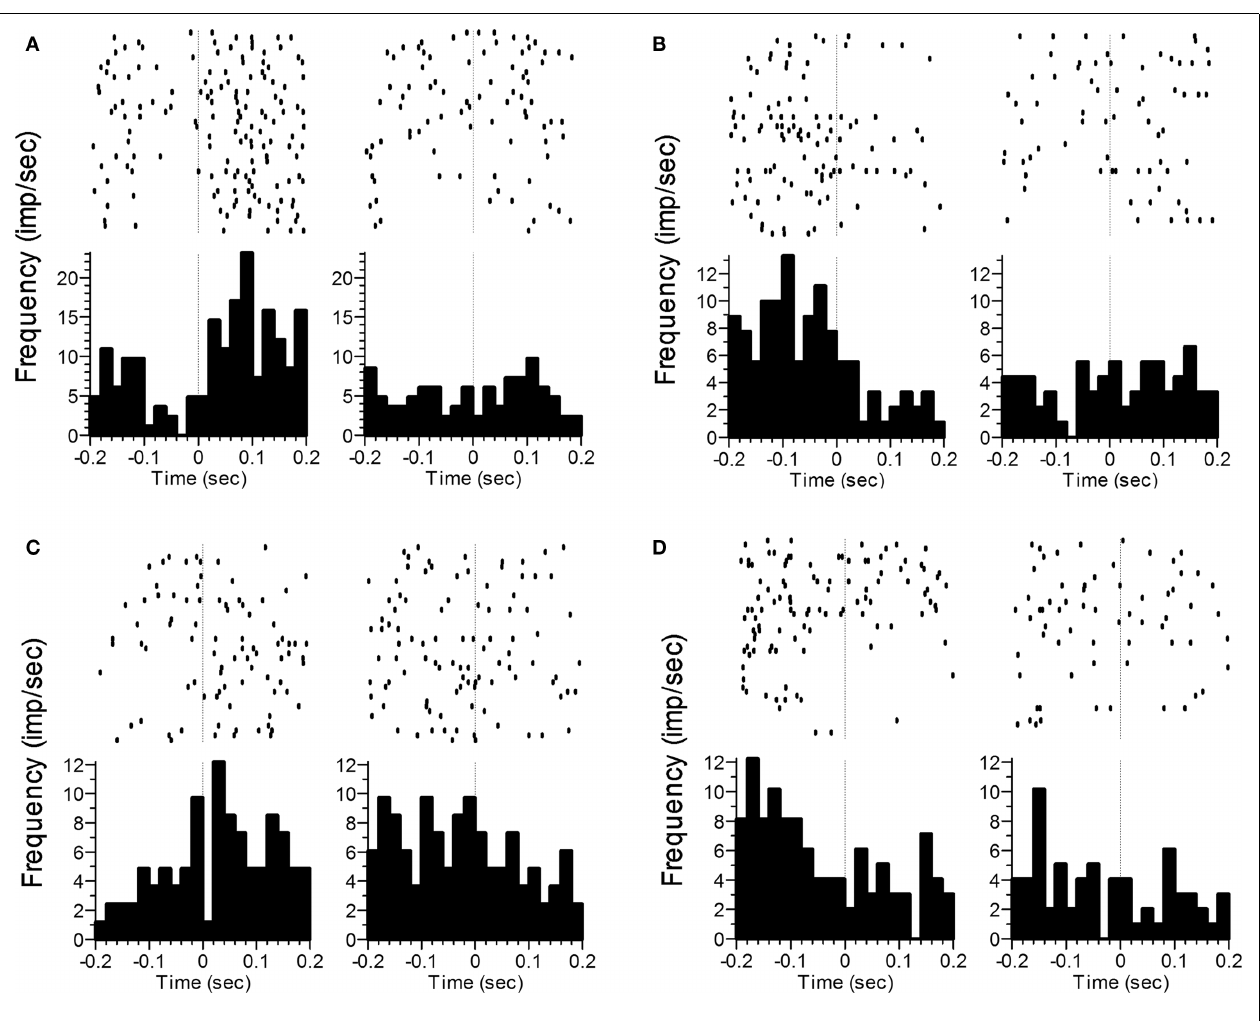
phase (A,B) or onset of the response phase (C,D) . Statistics analyses were performed on the time after poke offset in panels (A,B) , and prior to poke onset in panels (C,D) . In panels (A,C) , a significant difference as a function of Phase was seen. In panels (B,D) , significant effects were found for Phase, Time, and the Phase × Time